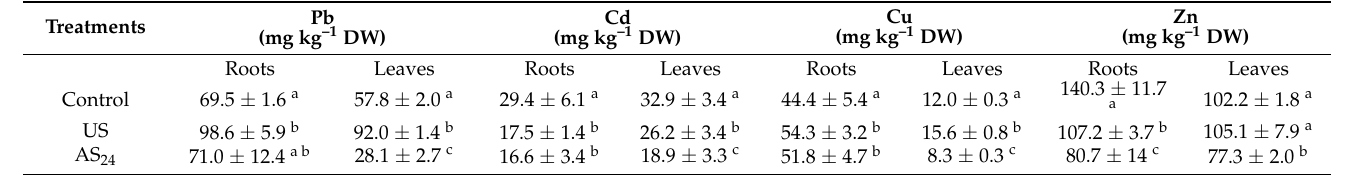
Table 5. Lead (Pb), cadmium (Cd), copper (Cu), and zinc (Zn) mass fraction in roots and leaves of control plants and in plants fertilized with untreated (US) and aerated (AS) slurry. Data are means ( n = 5) ± SE. Treatments